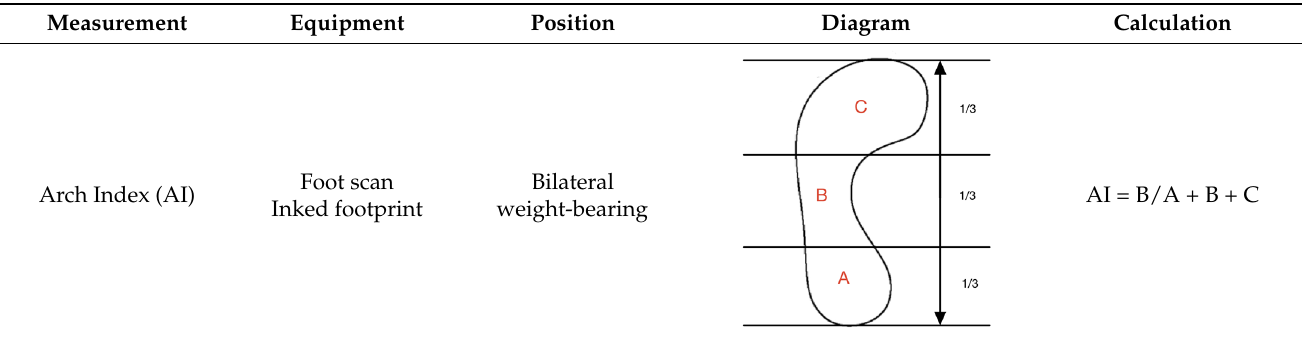
Table 2. A summary of the measures used to quantify the medial longitudinal arch.